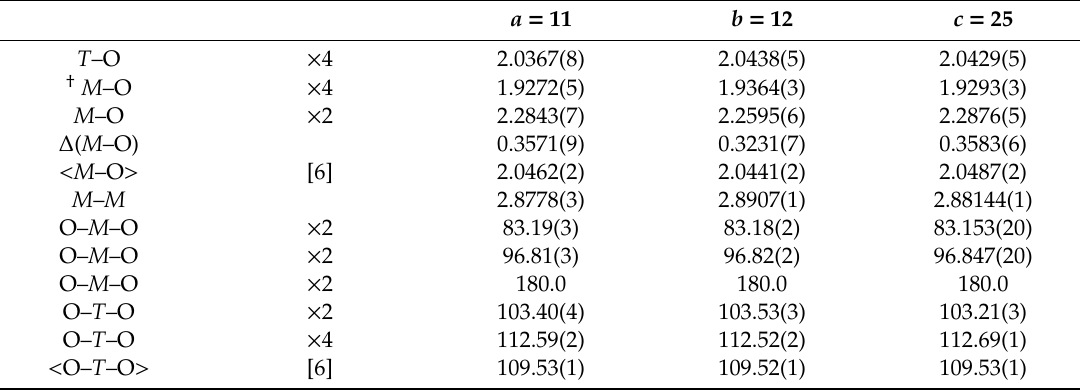
Table 7. Selected distances (Å) and angles ( ◦ ) for three hausmannite